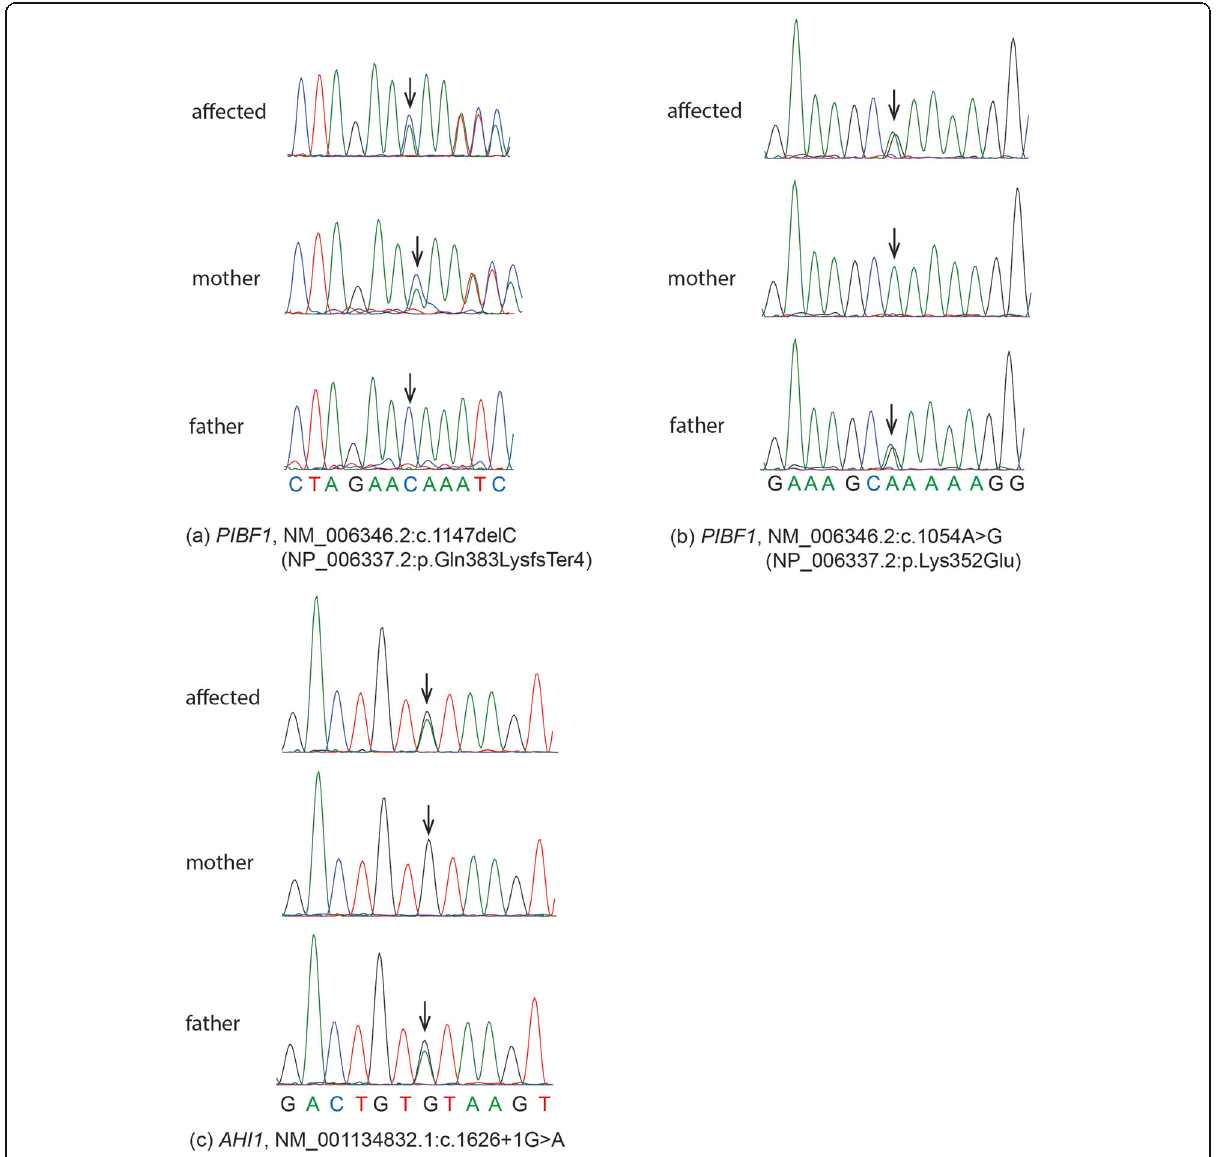
Fig. 2 Sanger chromatograms. a c.1147delC variant in PIBF1 in a heterozygous state in the proband (upper panel) and a heterozygous state in the mother (middle panel) and a wild-type homozygous state in the father (lower panel). b c.1054A> G variant in PIBF1 in a heterozygous state in the proband (upper panel) and a wild-type homozygous state in the mother (middle panel) and a heterozygous state in the father (lower panel). c c.1626 + 1G > A variant in AHI1 in a heterozygous state in the proband (upper panel) and a wild-type homozygous state in the mother (middle panel) and a heterozygous state in the father (lower